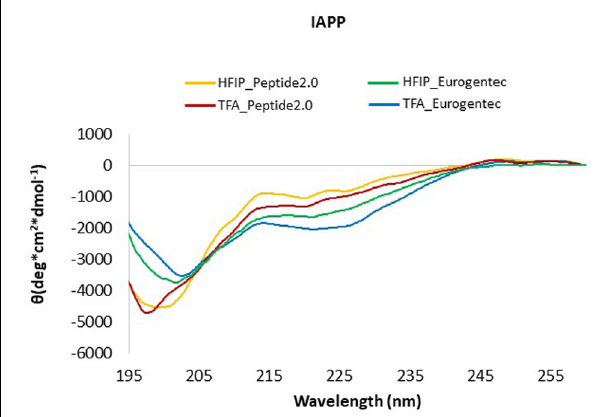
FIGURE 2 | CD Spectra of IAPP from different commercial sources. IAPP from Peptide2.0 pre-treated with HFIP (yellow line) or with TFA (red line); IAPP from Eurogentec after treatment with HFIP (green line) or with TFA (blue line). The spectra were acquired at 25 ◦ C in phosphate buffer pH